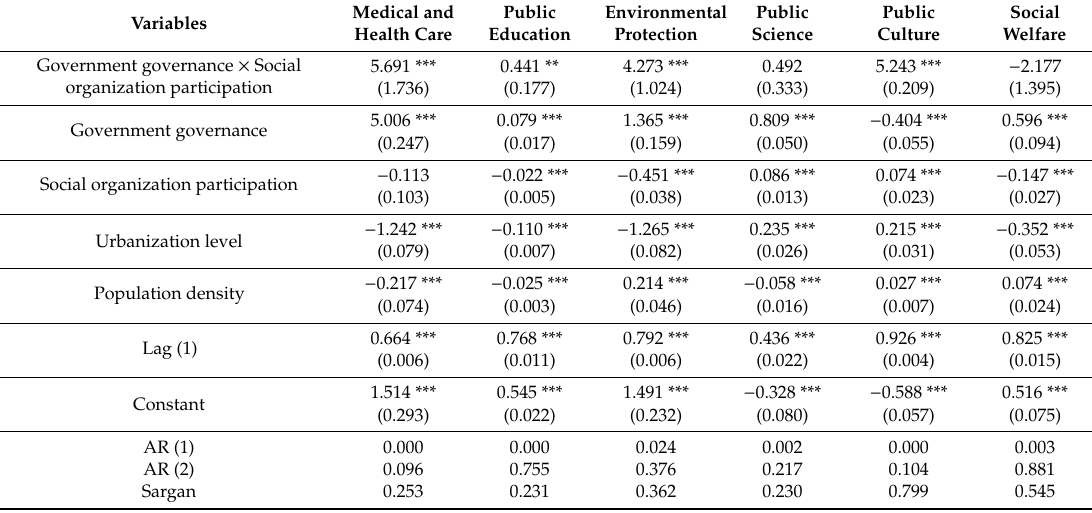
Table 9. Basic public service equalization heterogeneity